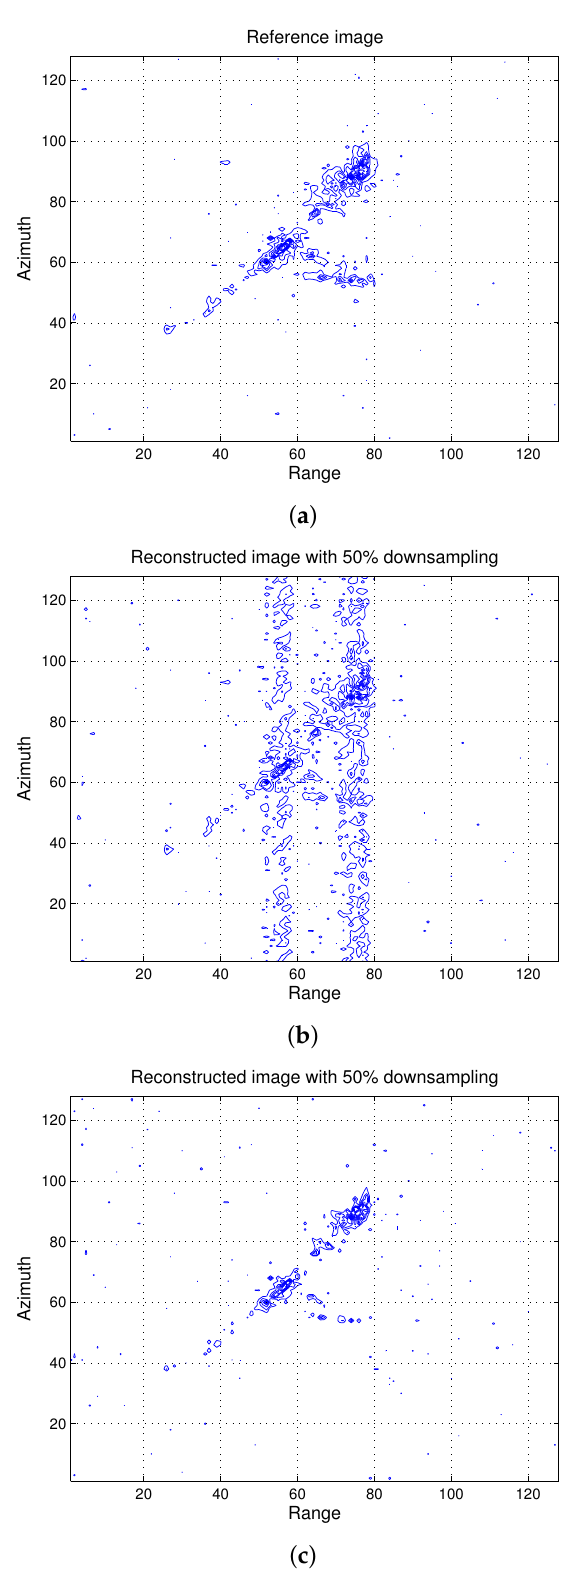
Figure 1. ( a ) Reference image; ( b ) reconstructed image using FT with 50% downsampled data; aliasing effects can be seen; ( c ) reconstructed image using Dictionary-based Genetic Algorithm Orthogonal Matching Pursuit (DGAOMP). The image is reconstructed without any